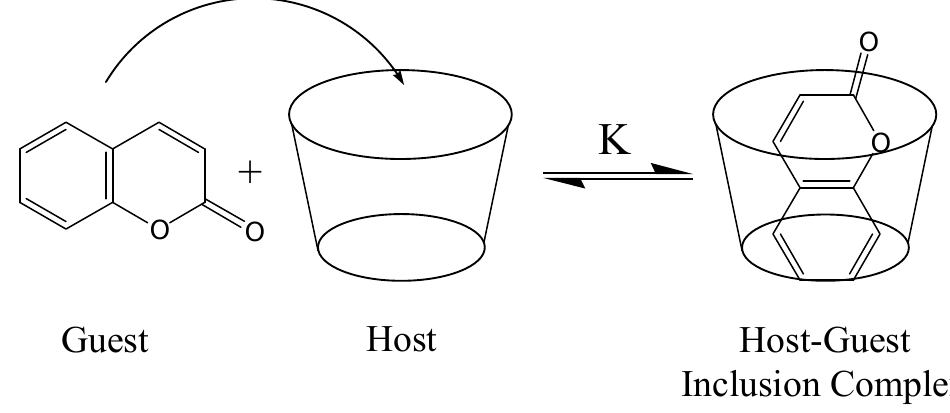
Figure 5 . A representation of the inclusion of a coumarin guest inside a host cavity, forming a host-guest inclusion